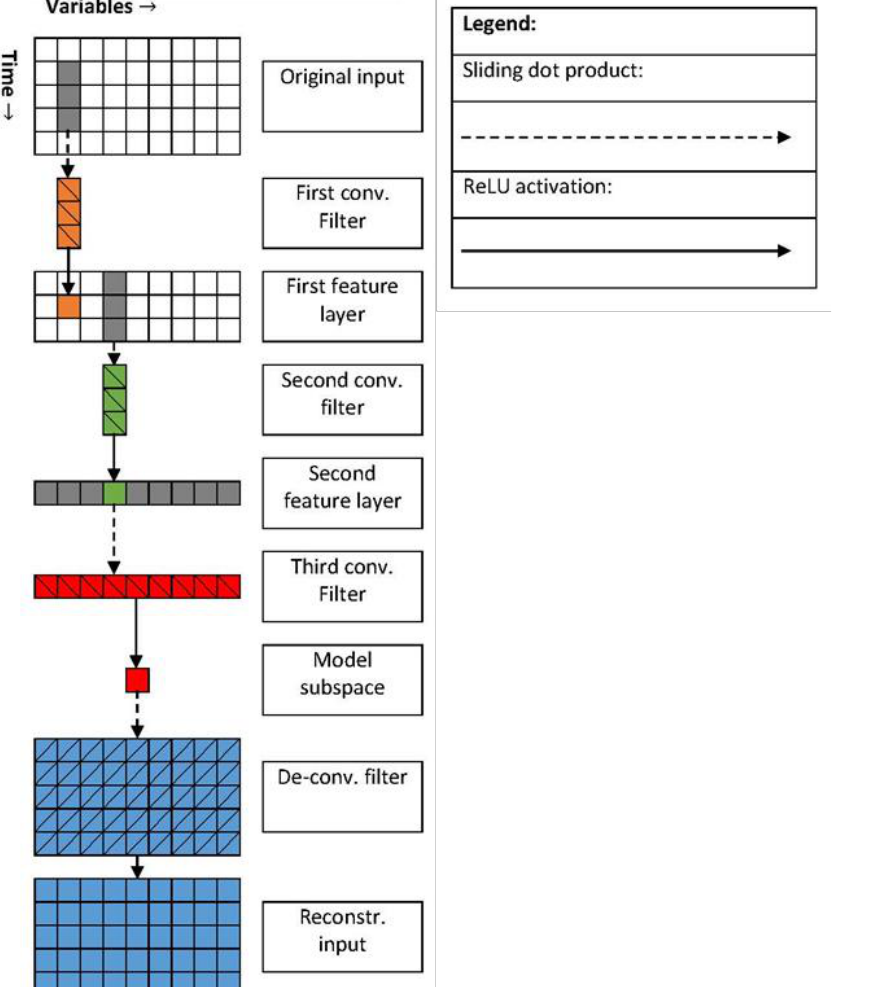
Table 8. Recognition thresholds selected for model evaluation.